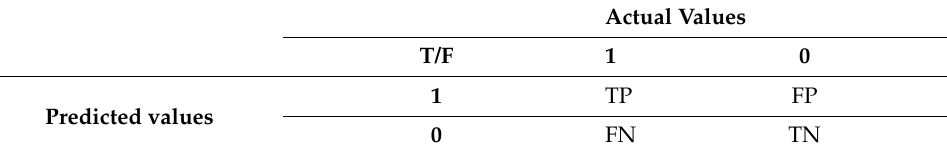
Table 2. Confusion